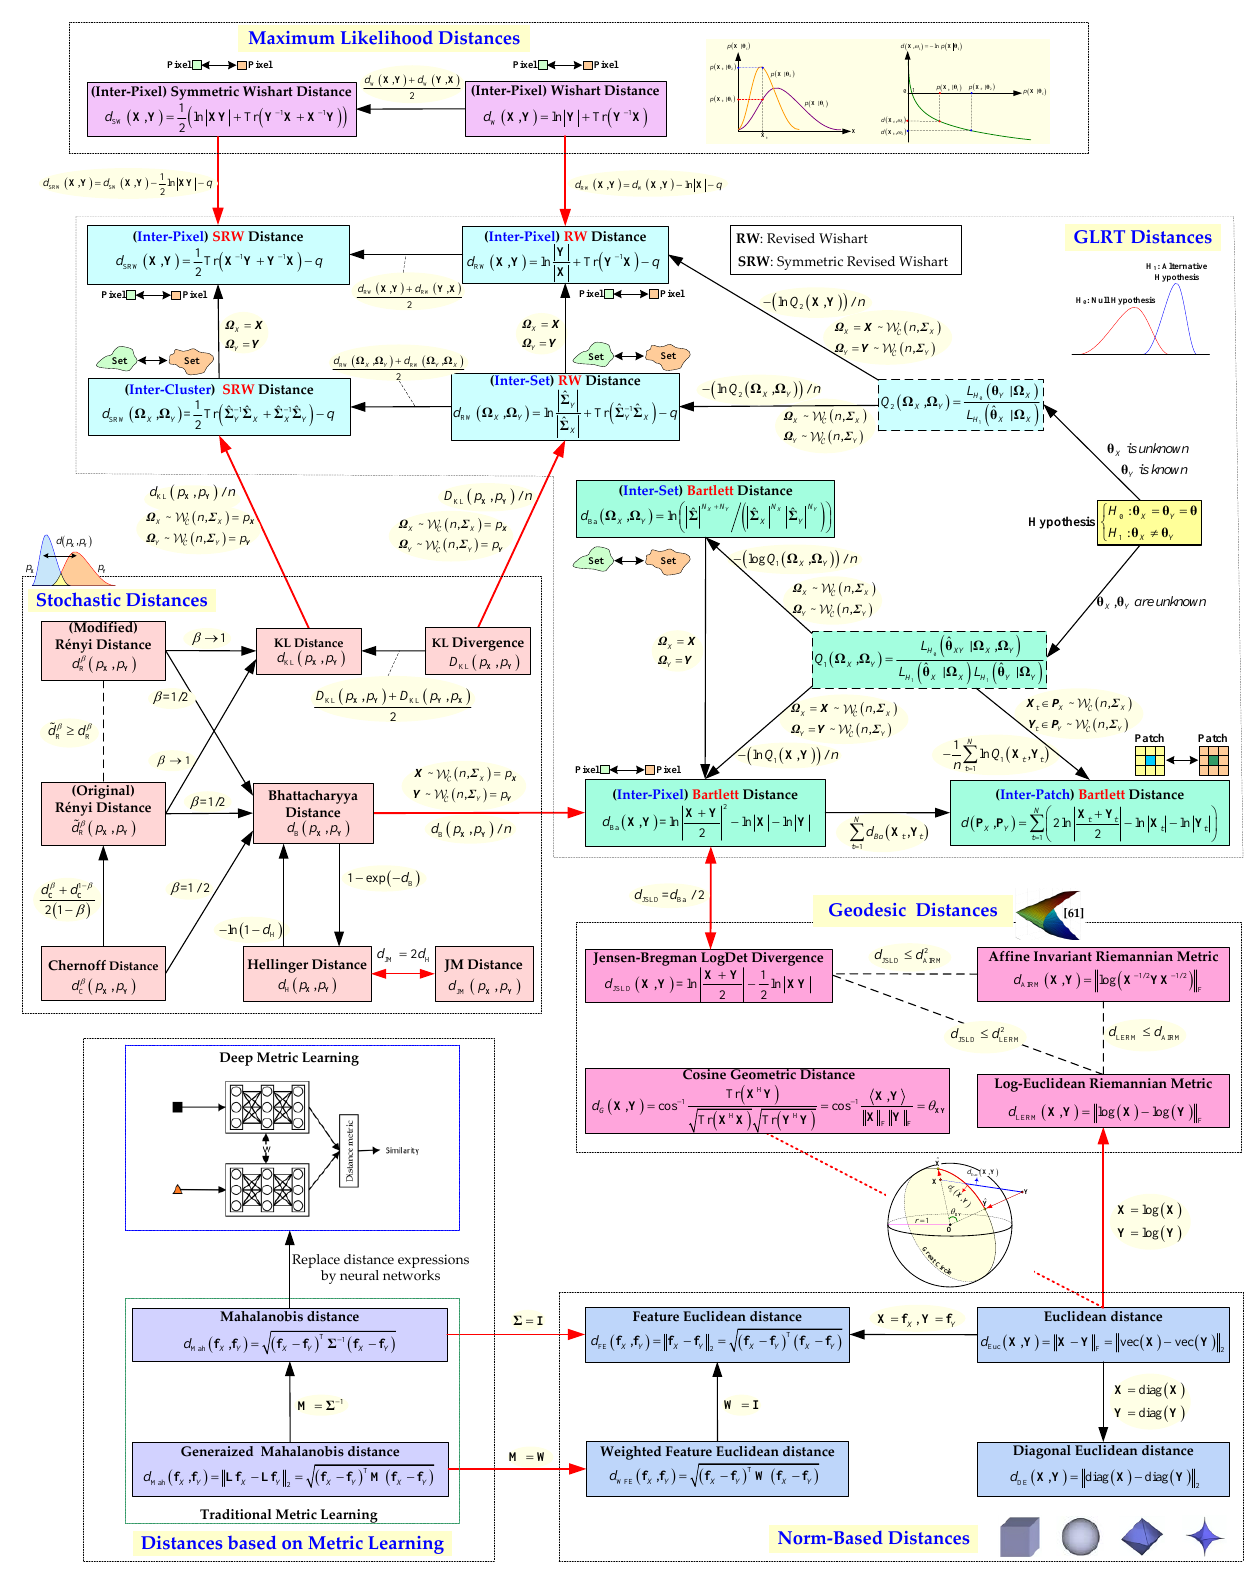
Figure 9. Relations between different distance measures of PolSAR image data.